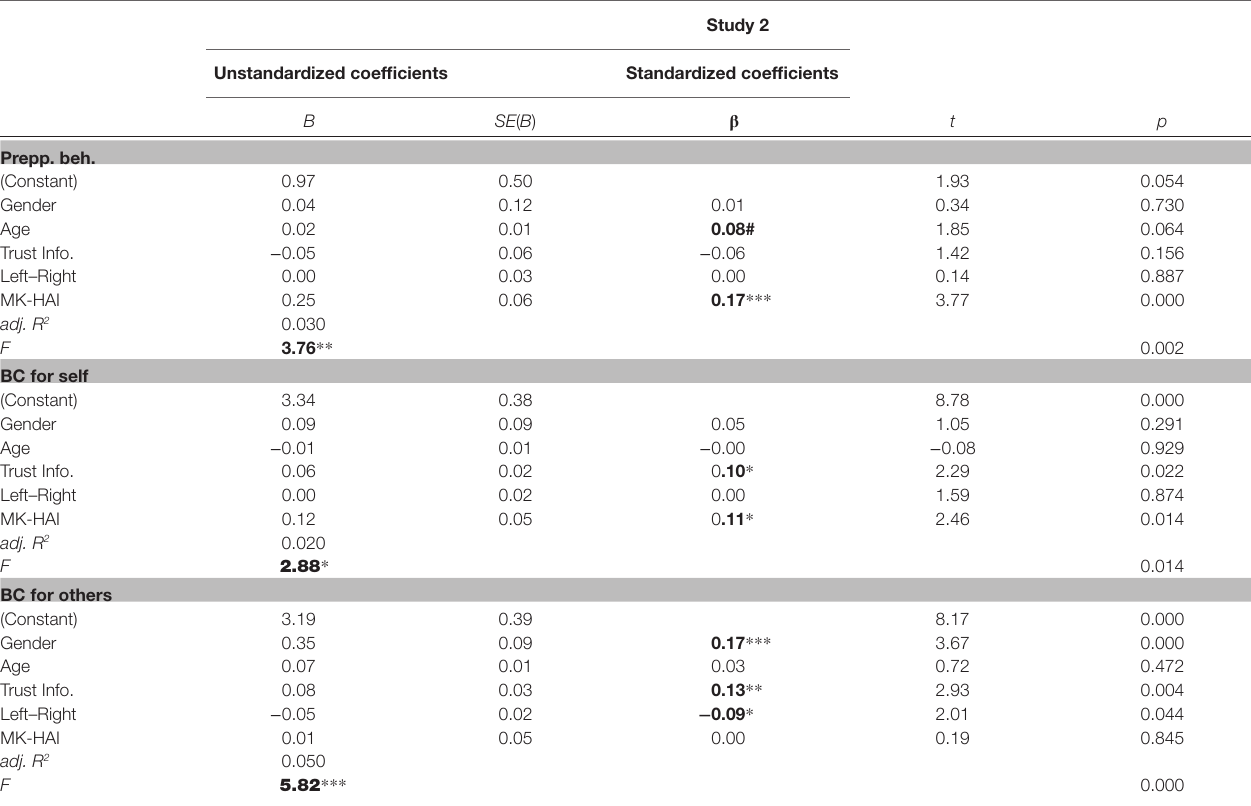
TABLE 5 | Multiple linear regressions on self-centered prepping behavior, behavior change to avoid infection, and behavior change in order to not infect others in Study